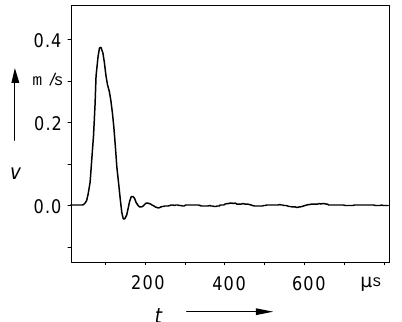
Fig. 12. Velocity curve of a measured high-level shock (Gaussian